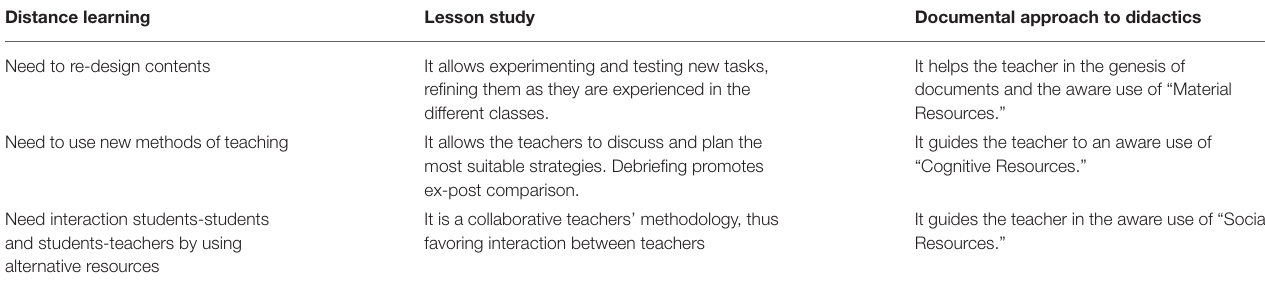
TABLE 4 | Debriefing document: Lesson Study results document. Distance